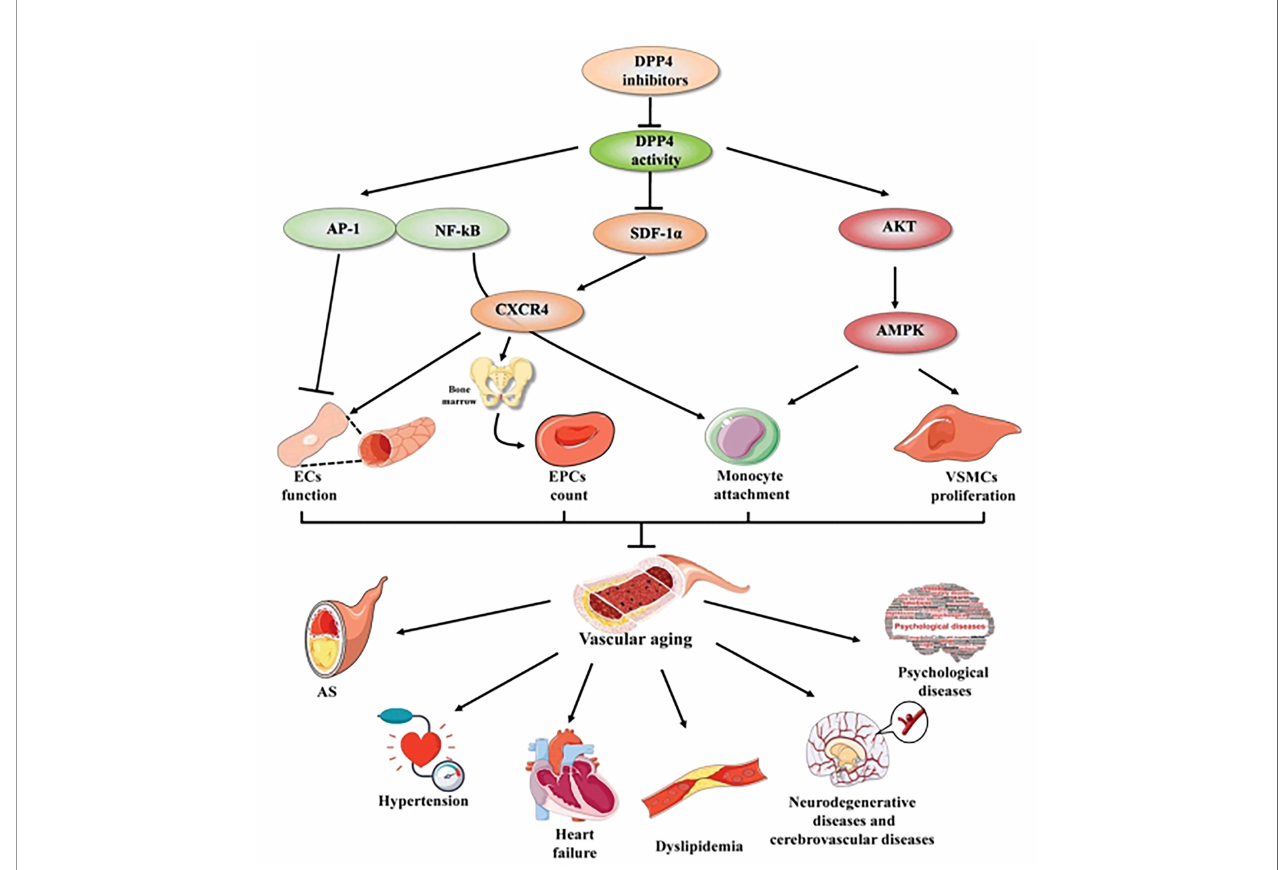
FIGURE 2 | The mechanisms of DPP4 inhibitors in vascular aging and vascular aging-related diseases. DPP4 inhibitors play a bene fi cial effect in vascular aging not only through multiple cellular mechanisms, including improving ECs function, increasing EPCs count, mediating the process of monocyte attachment and decreasing VSMCs proliferation, but also through complex molecular mechanisms, including AP-I and NF-KB signaling, SDF-1 a /CXCR4 axis and Akt/AMPK signaling pathway. Thereby preventing vascular aging-related diseases, compassing AS, hypertension, heart failure, dyslipidemia, neurodegenerative diseases and cerebrovascular diseases, psychological diseases. Arrows indicate stimulatory relationships, indicates inhibitory signal. AP-1, activator protein 1; NF- k B, nuclear factor kappaB; SDF- 1, stromal cell- derived factor-1 a ; CXCR4, C-X-C chemokine receptor type-4; Akt, v-akt murine thymoma viral oncogene homologue; MAPK, mitogen-activated protein kinase; ECs, endothelial cells; VSMCs, vascular smooth muscle cells; EPCs, endothelial progenitor cell; AS, atherosclerosis. Arrows indicate stimulatory relationship, non-arrows indicate inhibitory